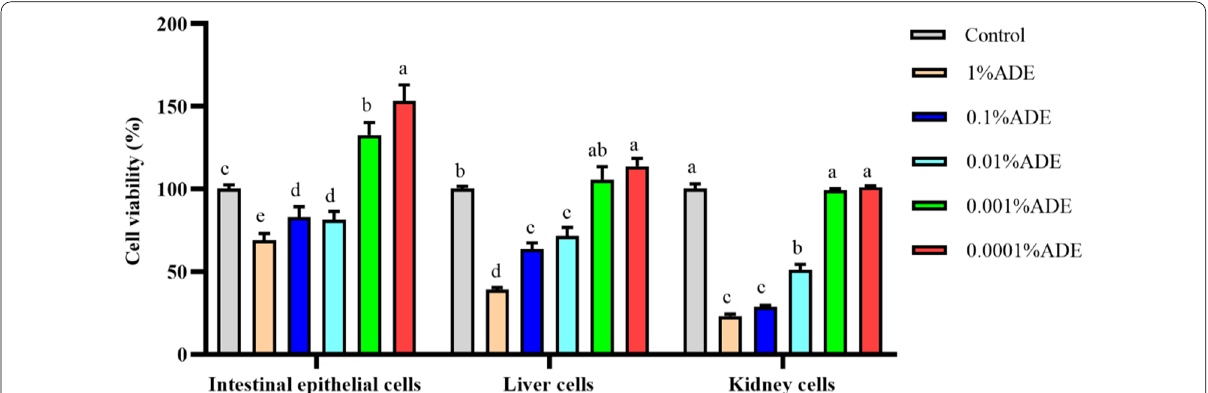
Fig. 2 Effects of ADE on viabilities of primary intestinal epithelium, liver and kidney cells (n significant difference from each other ( p < 0.05), while the same letters on each bar indicate insignificant difference from each other ( p > 0.05). ADE AFB 1 ‑degradation enzyme